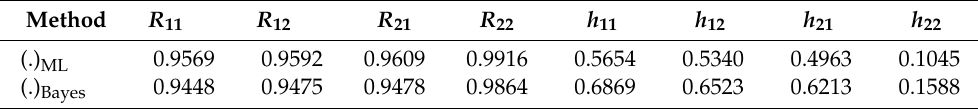
Table 8. Point estimates of the reliability and failure rates at t =